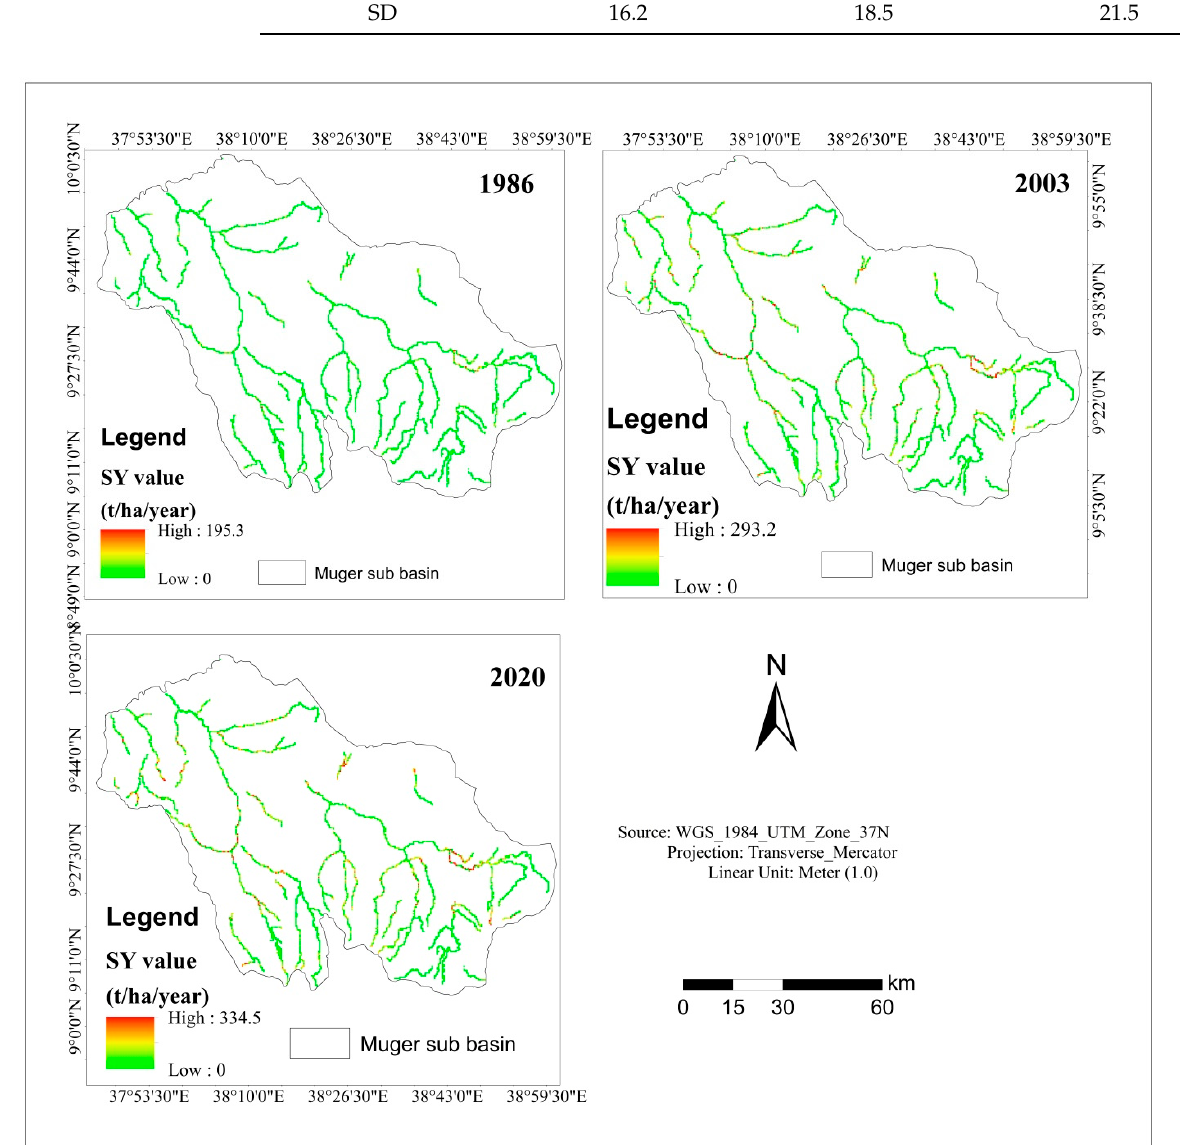
Figure 11. Map of sediment delivery ratio (SDR) the Muger Sub-basin.